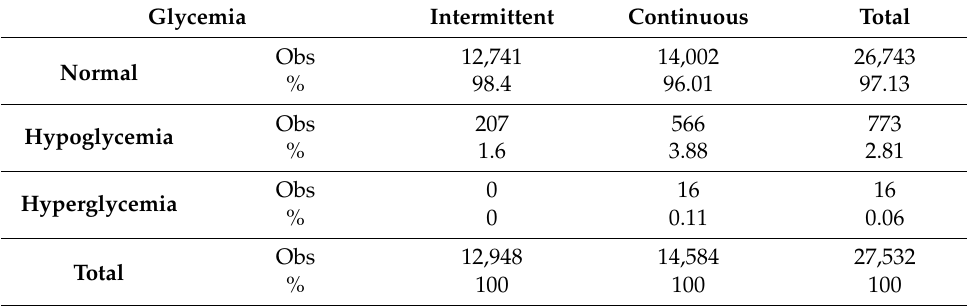
Table 3. Association between type of nutrition and blood glucose alterations. Glycemia